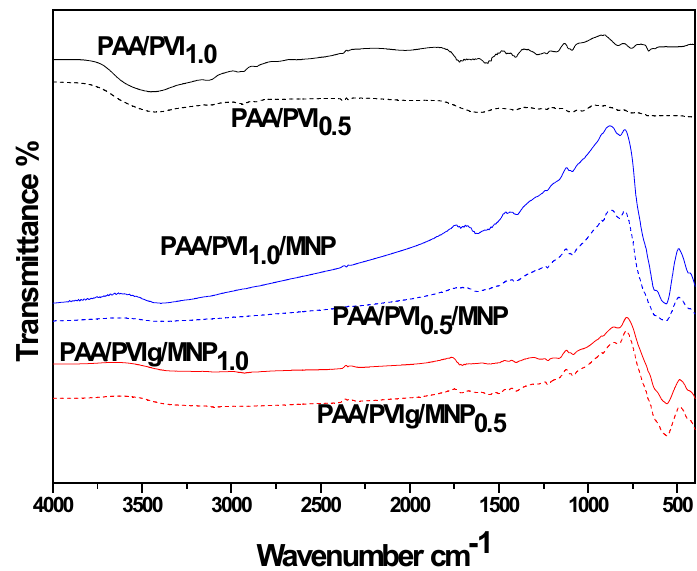
Figure 6. FT-IR thermograms of a) PE-1 b) PE-2 c) NPE-1 d) NPE-2 e) NPE-3 f)